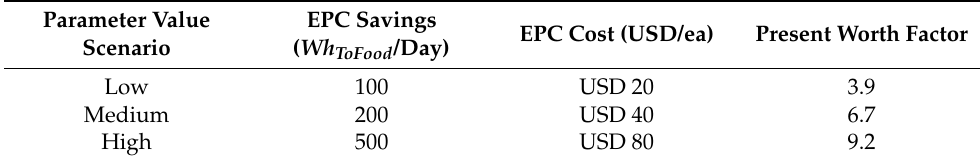
Table 7. MLCOE input parameter ranges for estimating EPC electricity savings costs in a DDS